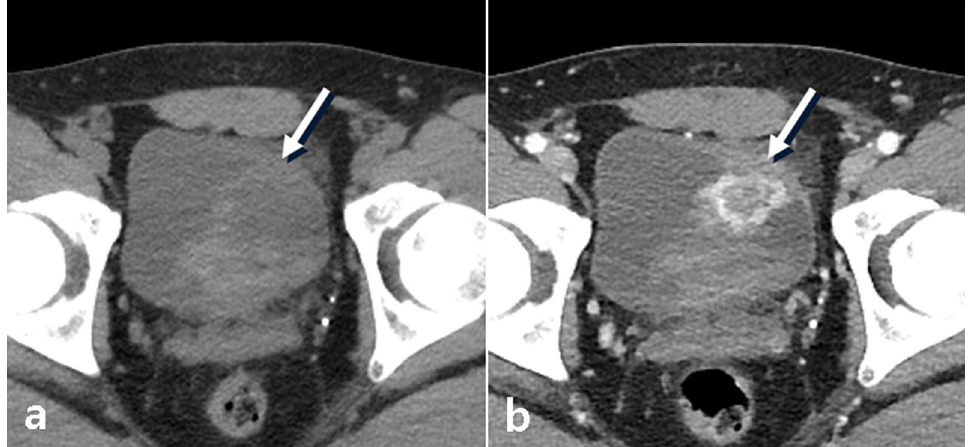
Fig. 12 A 40‑year‑old male patient with an inflammatory myoblastic tumor of the bladder. Axial pre‑contrast ( a ) and post‑contrast ( b ) CT images showing a single poorly marginated intraluminal polypoid mass with avid ring enhancement (arrow)